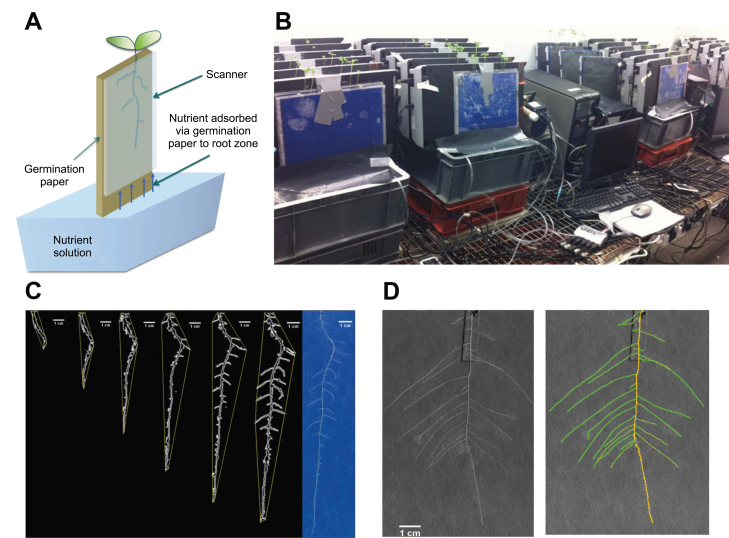
(A) Schematic representation of the pouch-and-wick system used to grow plants in the phenotyping platform. Roots grew on the surface of germination paper held between a clear-Perspex plate and the glass window of a scanner. Scanners were fixed in near-vertical positions 5cm above 20 l of nutrient solution contained in opaque polyvinyl plastic tanks each supplying six scanners. Approximately 10cm of the germination paper was submerged in the nutrient solution. (B) The phenotyping platform comprising 24 scanners assembled in four banks of six scanners. (C) The features of a root system, including the convex hull, at successive timepoints obtained using customized ImageJ macros, including the root system at the last timepoint. (D) The features of a root system at a specific timepoint obtained using the SmartRoot plugin for ImageJ.